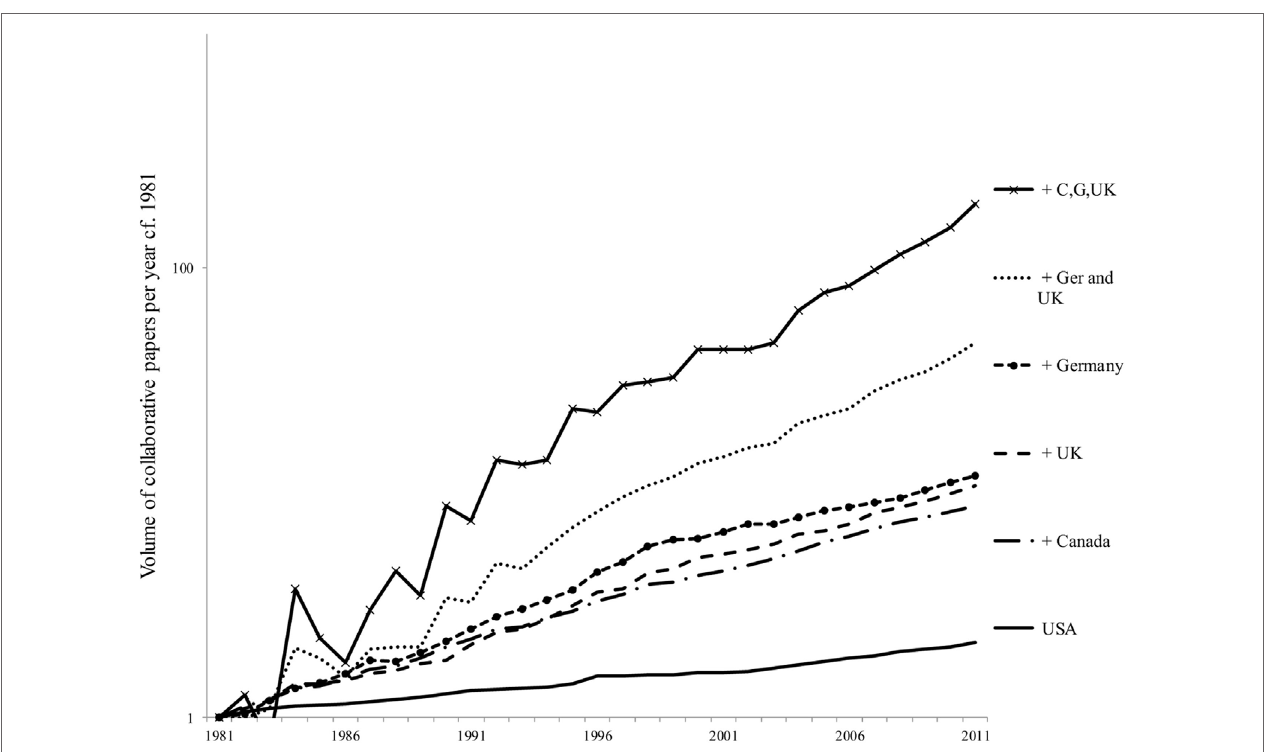
FigUre 1 | Increase in the relative frequency (log scale) of papers for the USA with co-authors from frequent partner countries [Canada (C), UK, Germany (Ger, G)]. Data shown with most frequent collaborators both singly and in collaboration; other countries may also co-author on any or all of these papers. The data show that the increase in collaboration with multiple partners is more rapid than the increase in output as a